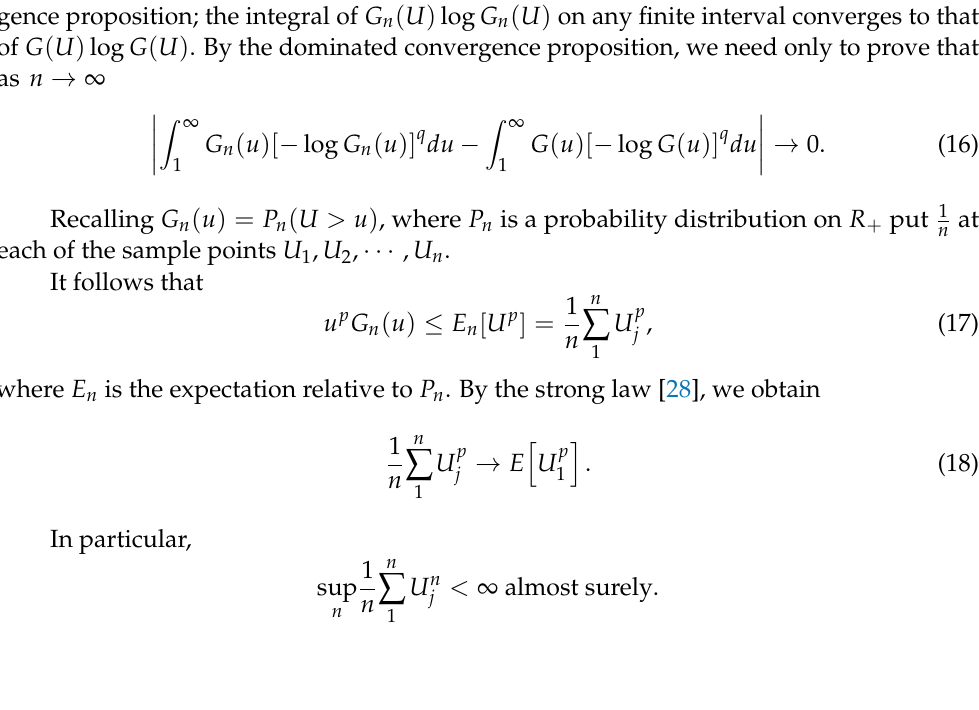
(cid:0) (cid:1) U 2 /2 E ( U )